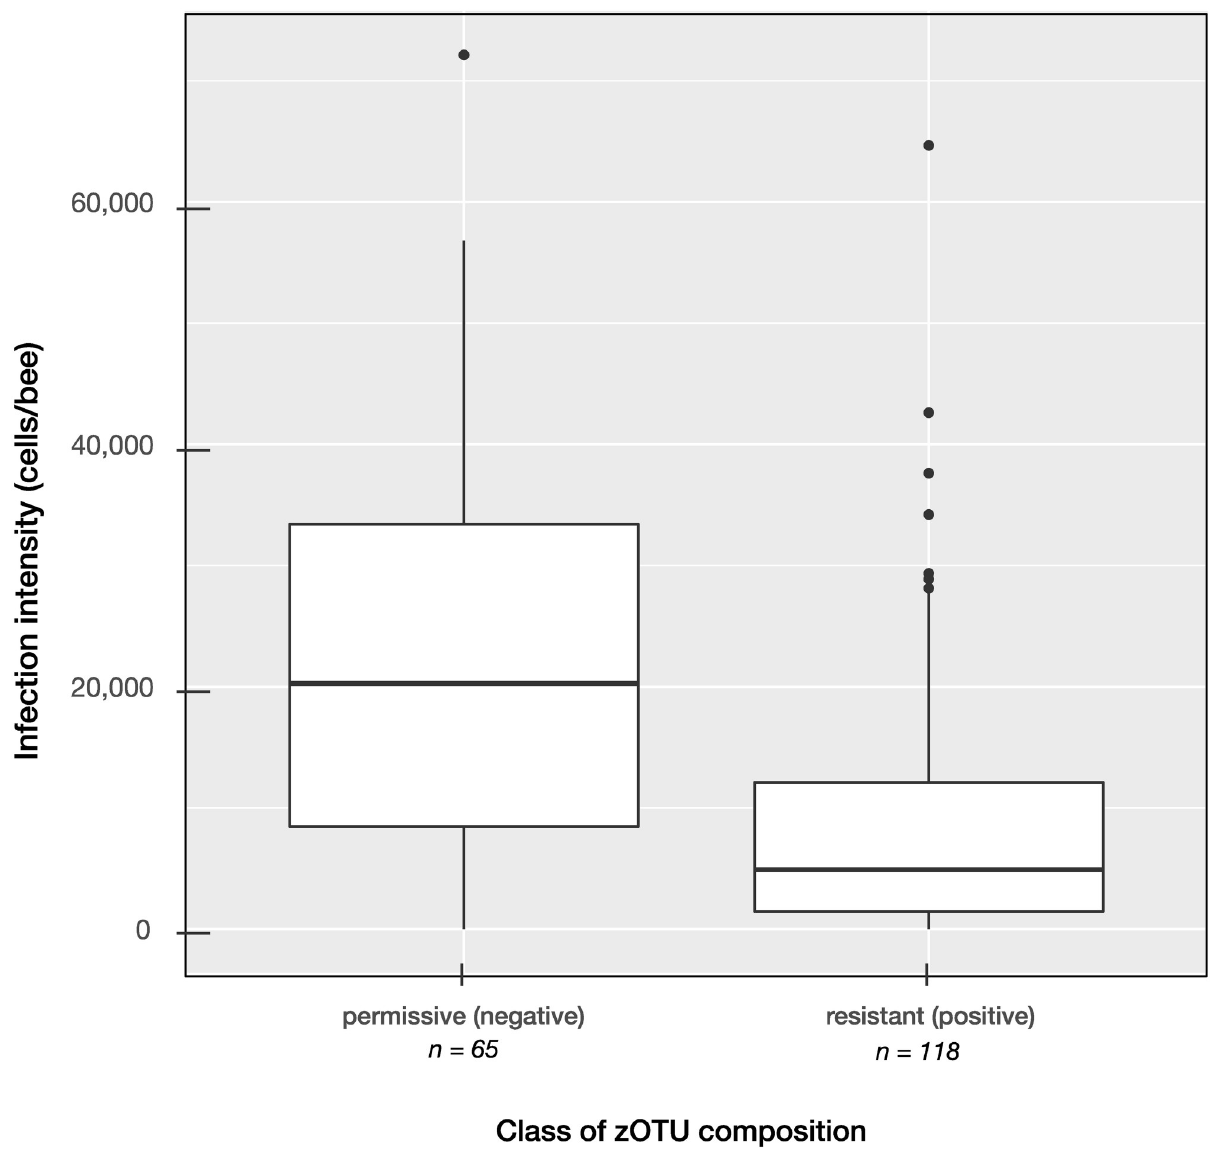
Fig 4. Infection intensity with respect to zOTU composition group. Samples were separated by multi-dimensional scaling (see Fig 3) and grouped by the value of their first component (Axis 1 < 0, or Axis 1 � 0). The ’negative’ group (’permissive’) had significantly higher infection intensities than the ’positive’ (’resistant’) group (Walsh’s t = 6.12, p � 0.0001, df = 95.6). zOTU-distances based on wuf .